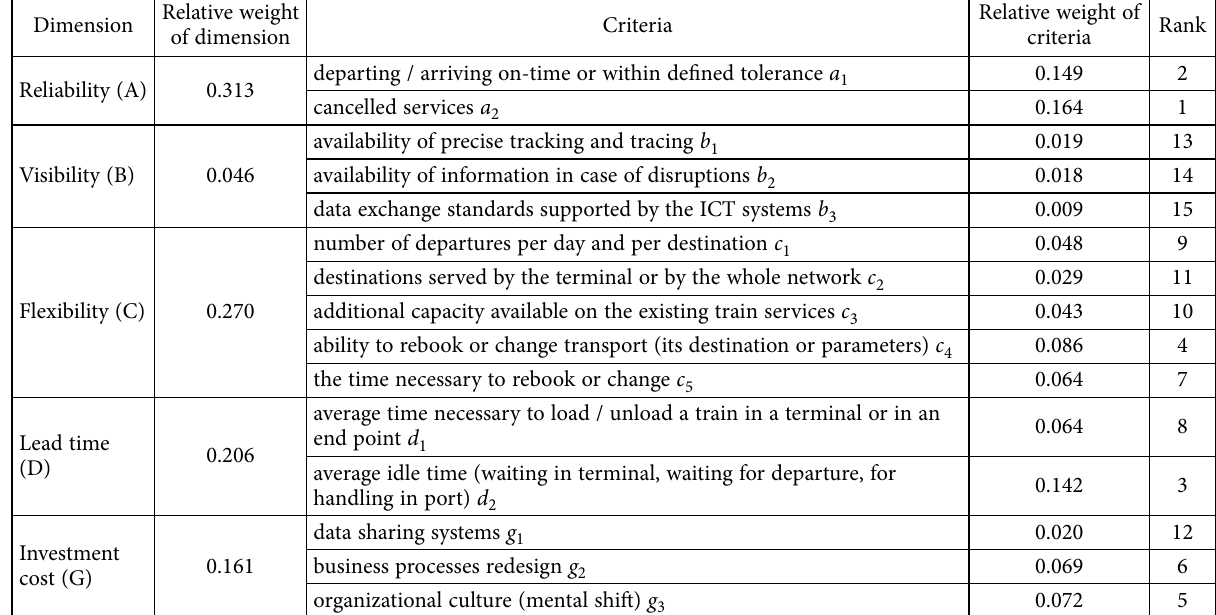
Table 5. Influential weights of DEMATEL–ANP for each criterion obtained